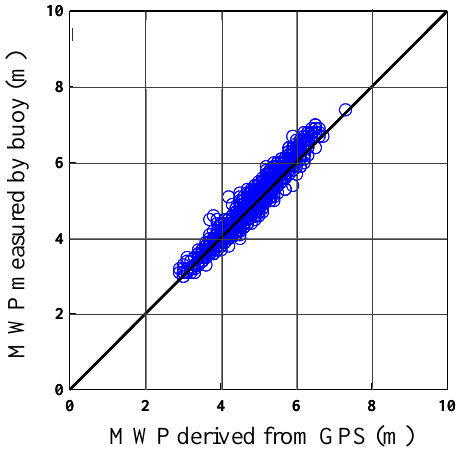
Figure 15. Comparison of mean wave period (MWP) between the buoy-measured with GPS-derived.